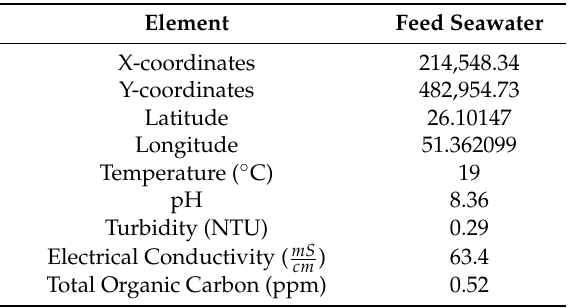
Table 1. The physico-chemical parameters of the seawater sample collected from Al-Ghariyah beach.